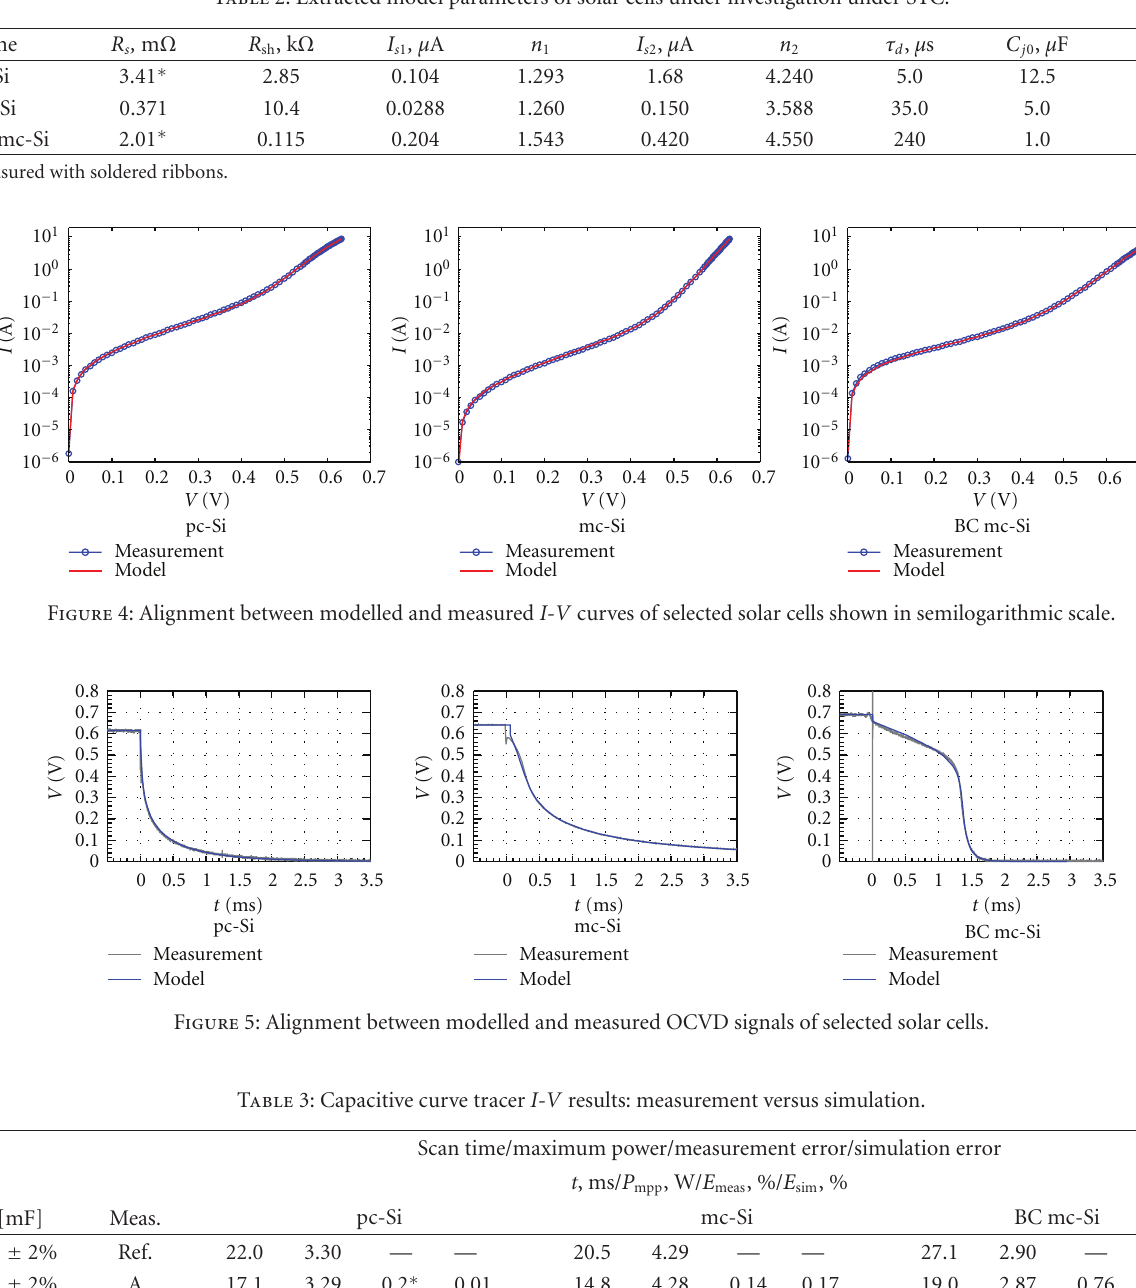
Table 2: Extracted model parameters of solar cells under investigation under STC.